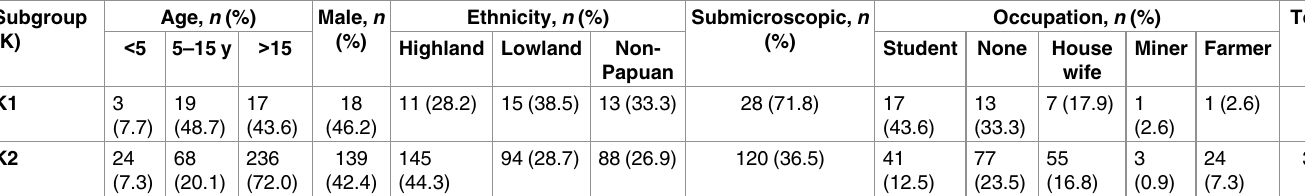
Table 4. P . falciparum subpopulation 1 and 2 demographic